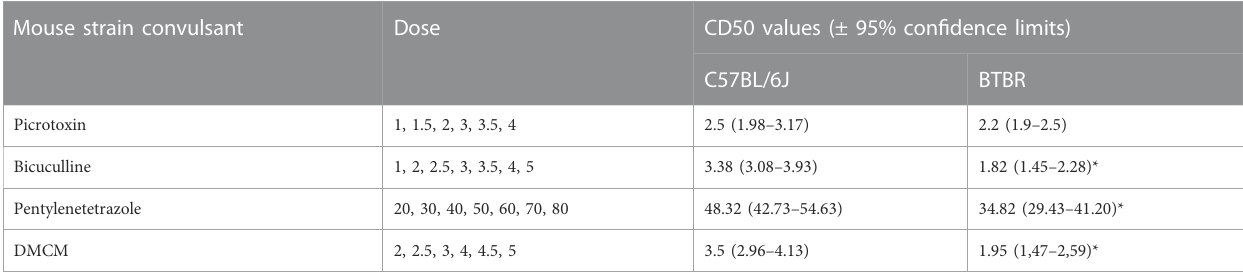
TABLE 1 Seizure susceptibility of C57BL/6J and BTBR mice to convulsant drugs acting on the γ -aminobutyric acid – benzodiazepine receptor A. All data reported in the present table are expressed as mg/kg i.p. Mouse strain convulsant